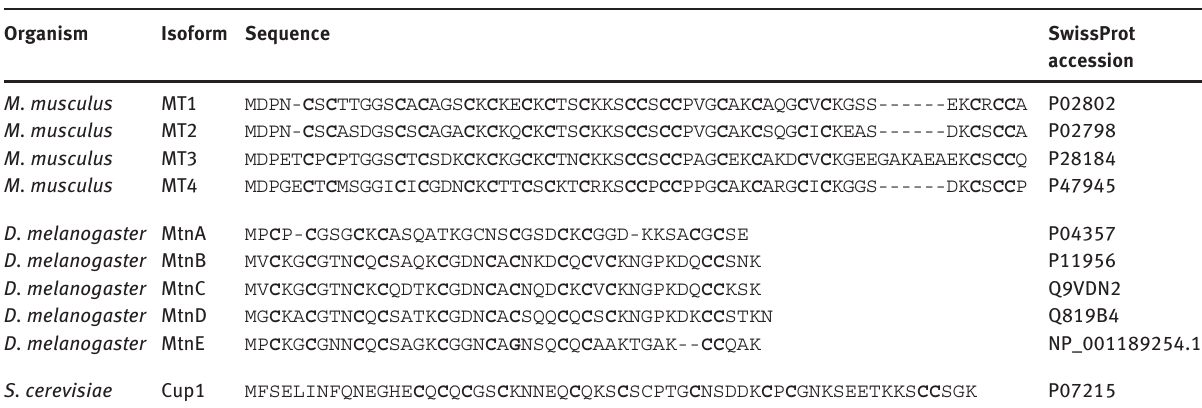
Table 1 Amino acid sequence of the metallothionein proteins included in this review, with indication of the accession number in the UniProt-SwissProt data bank or NCBI a